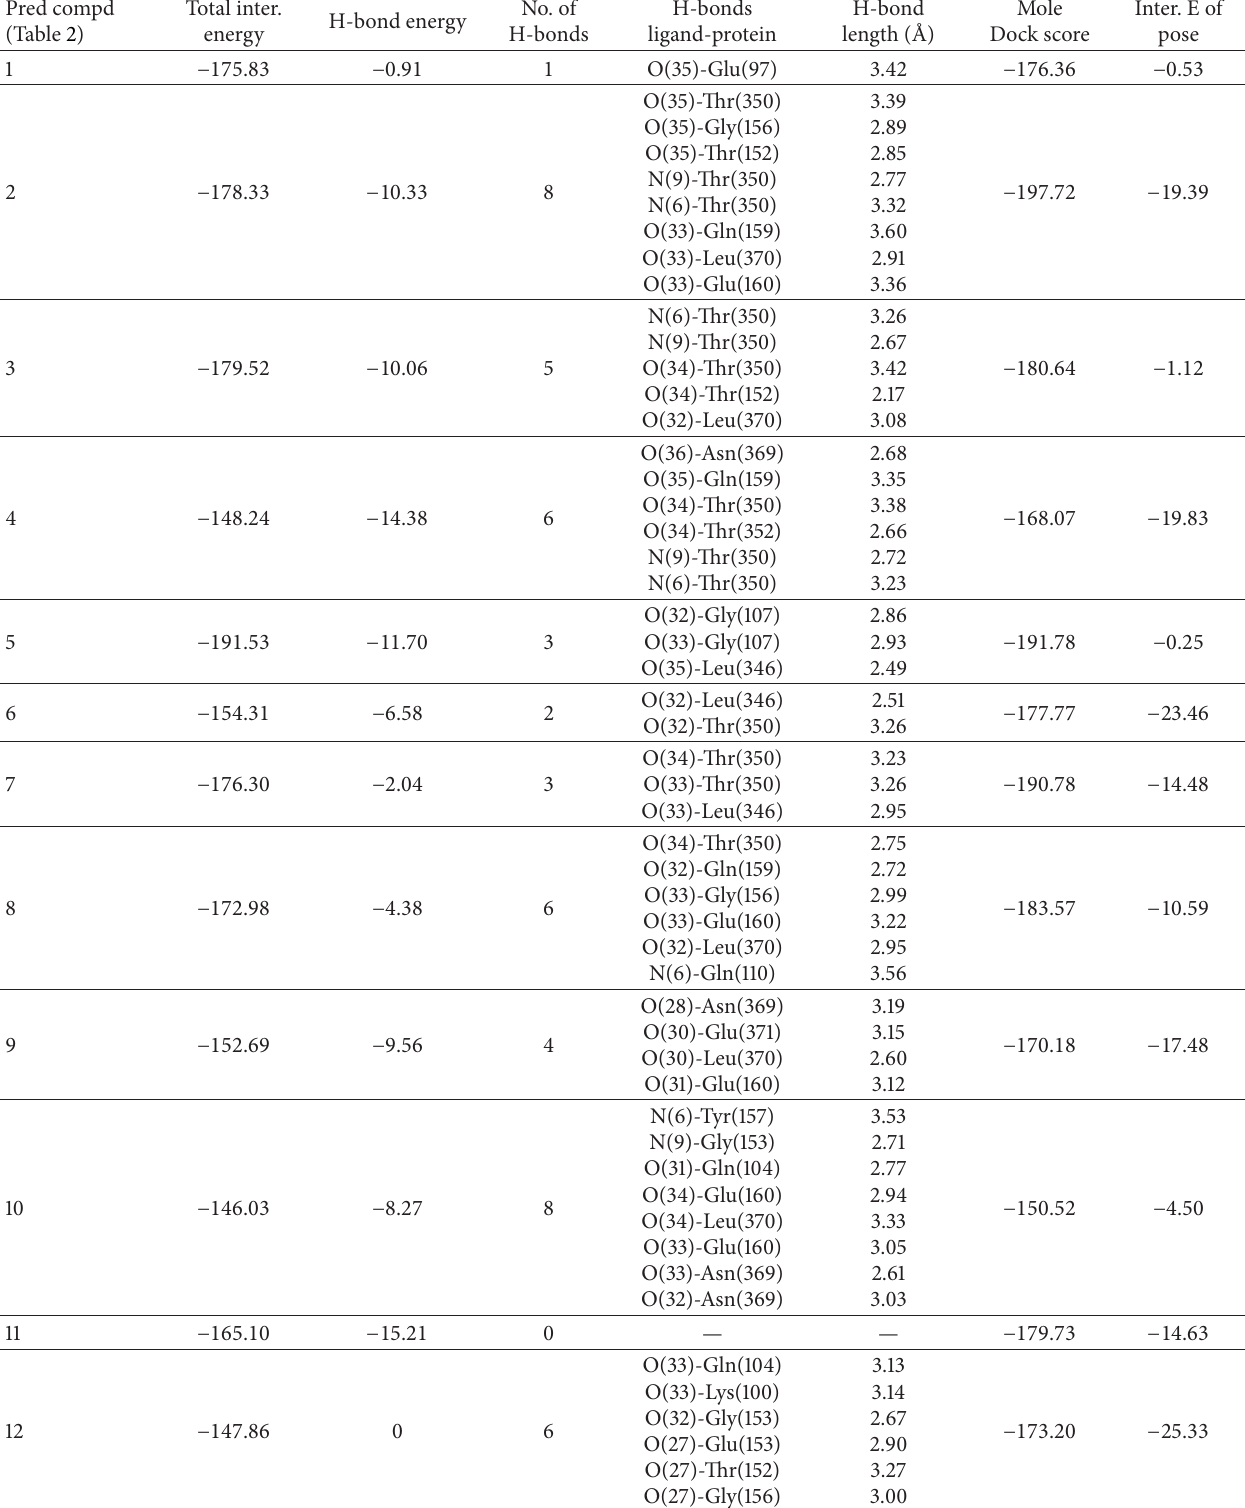
Table 3: Docking results of predicted compounds with reference to the active drugs available in the market (last four in the table) to treat the hyperacidity and GERD. Energy values are in